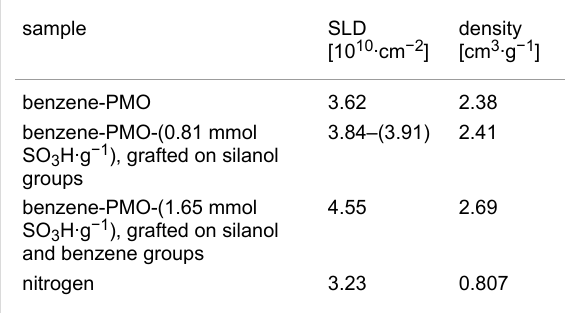
Table 1: Neutron scattering length densities (SLDs) and densities of benzene-PMO, the two SO 3 H-functionalized benzene-PMOs and